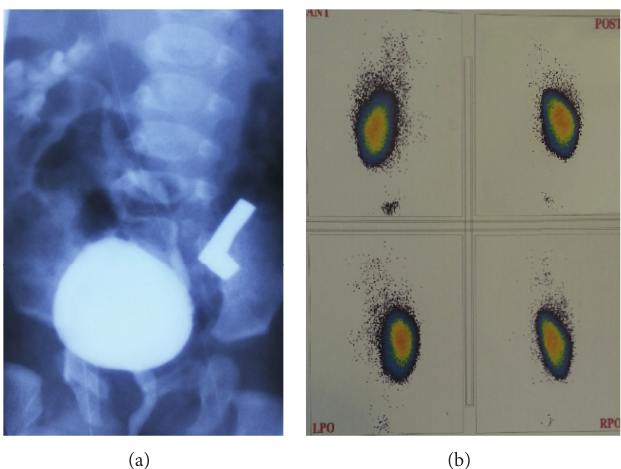
Figure 1: (a) VCUG, anteroposterior view showing VUR; ureter is seen crossing the midline from left to right side at the L5 level. (b) DMSA renal scan demonstrates absent activity in the left renal bed with acceptable cortical function of the right kidney.